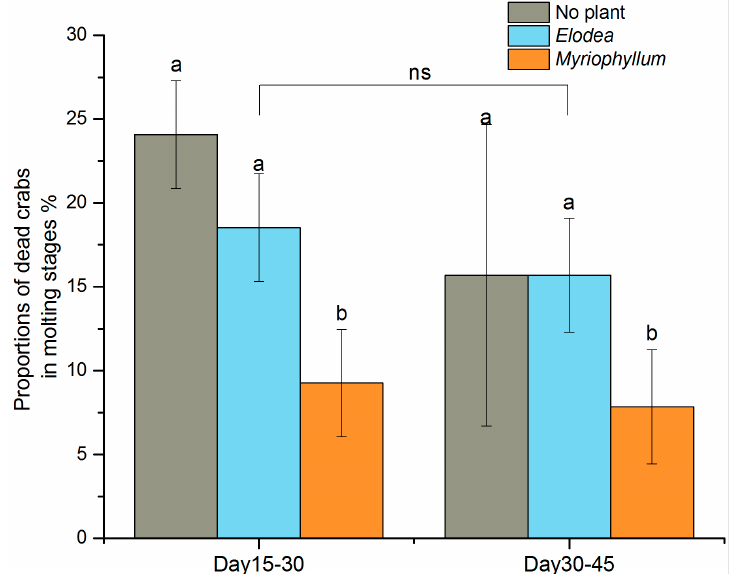
Figure 5. Influence of plants on the proportion of dead juvenile crabs in the molting stages during the two experimental periods. Error bars represent standard deviation ( n = 3, %). Different letters above the bars denote significant differences between the treatments for each experimental period at p < 0.05, while ns indicates no significant differences between the two experimental periods.